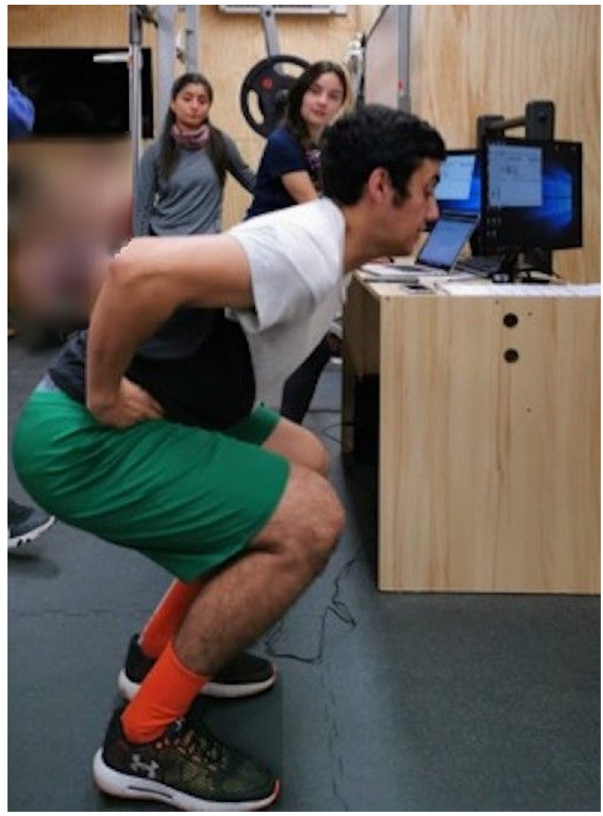
Fig 1. A participant being tested in the countermovement jump exercise by two female